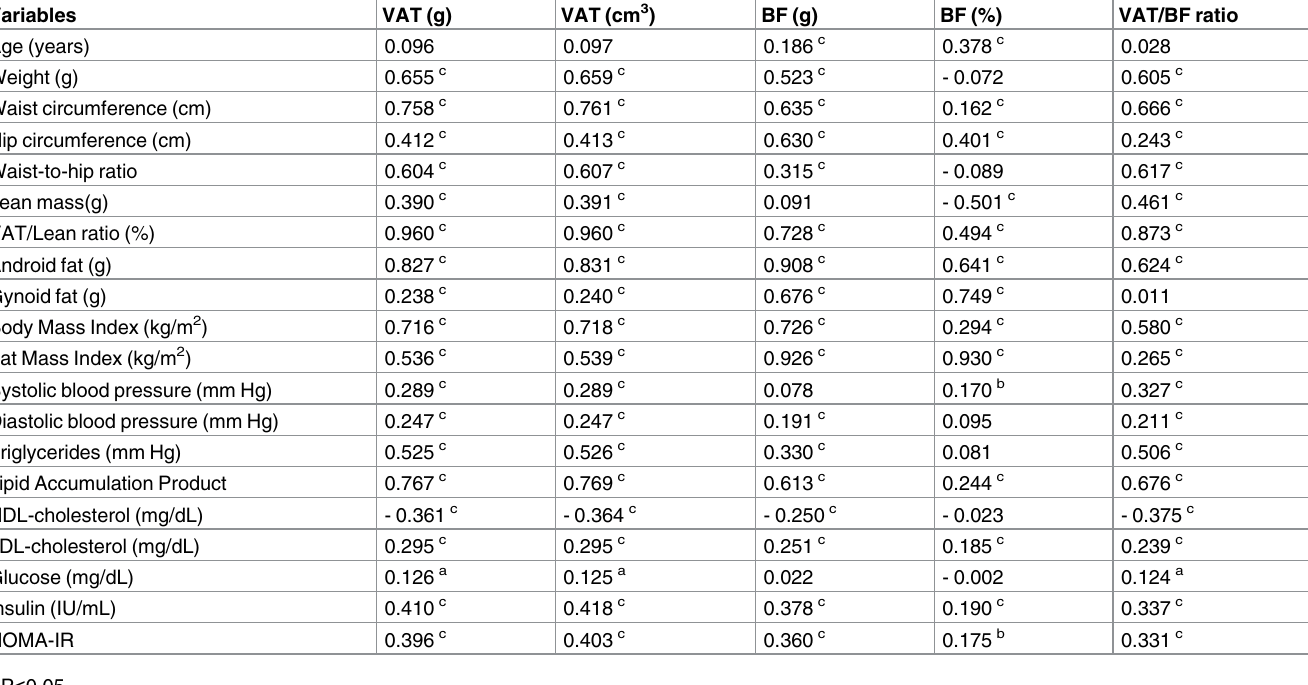
Table 3. Correlation coefficients between VAT, body fat, anthropometric indices, blood pressure, blood lipids and HOMA-IR (males and females